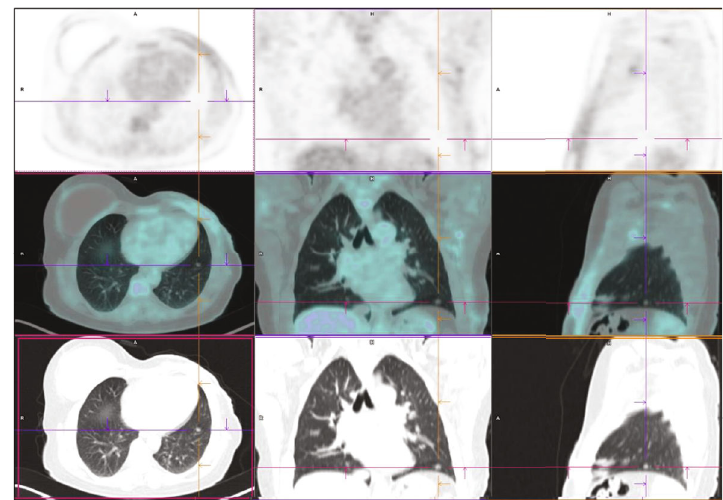
Figure 2: PET/CT images showing an increased metabolic activity in the pulmonary suspected lesion.